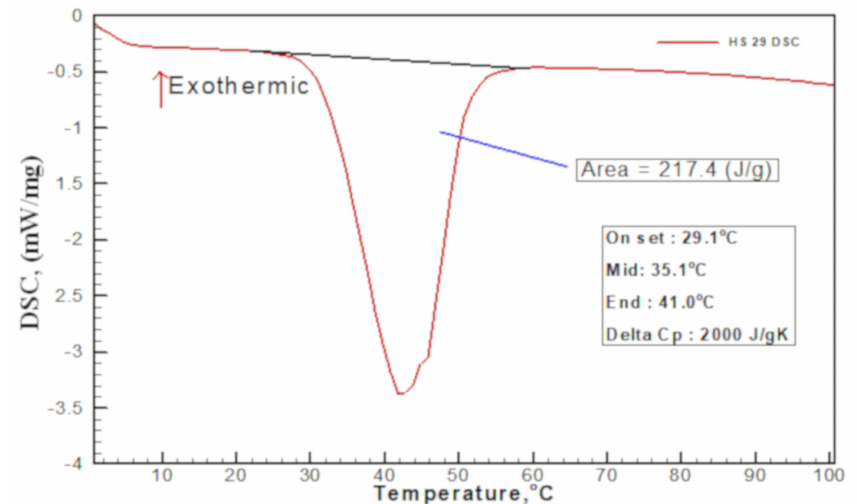
Figure A1. DSC measurement for HS 29.